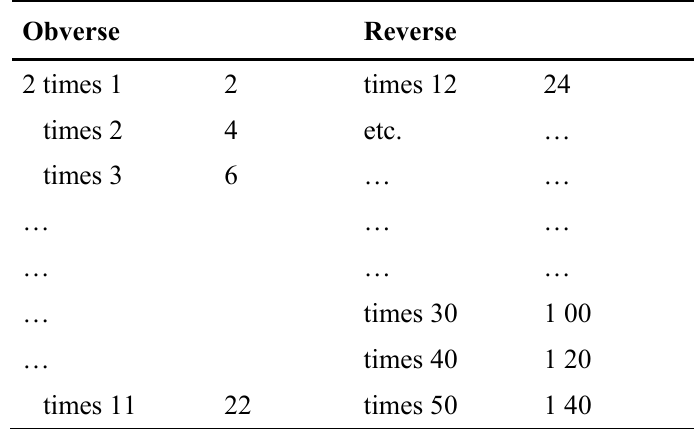
Figure 2 : The 2 times tables taken from the Babylonian